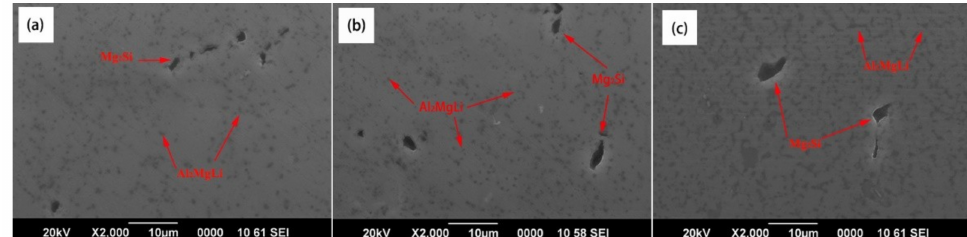
Figure 6. SEM images of equal-channel-angular pressing (ECAP) 16-pass Al-5.5Mg-xLi-0.1Zr (wt%) alloy with di ff erent Li contents: ( a ) 1.6 wt%, ( b ) 2.0 wt%, ( c ) 2.5 wt%.